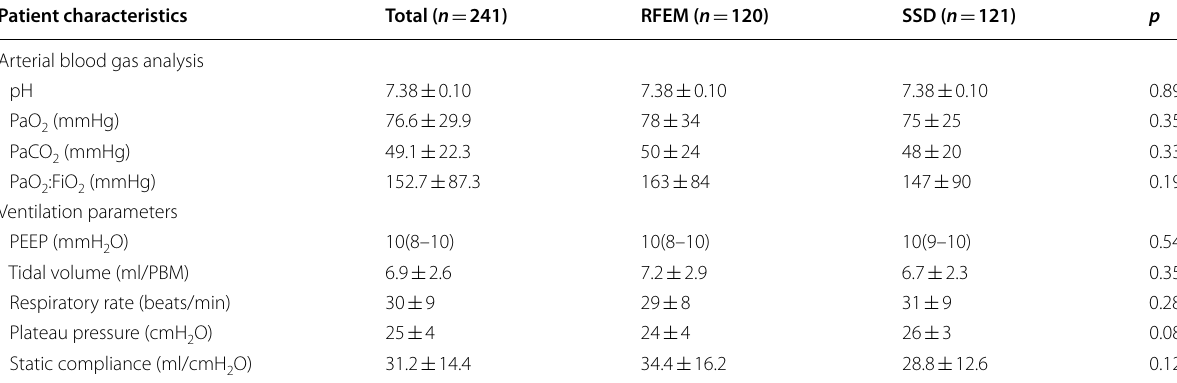
PaO 2 partial pressure of arterial oxygen, PaCO 2 partial pressure of arterial carbon dioxide, PaO 2 :FiO 2 the ratio of the partial pressure of arterial oxygen to the fraction of inspired oxygen, PEEP positive end-expiratory pressure, PBM predicted body weight